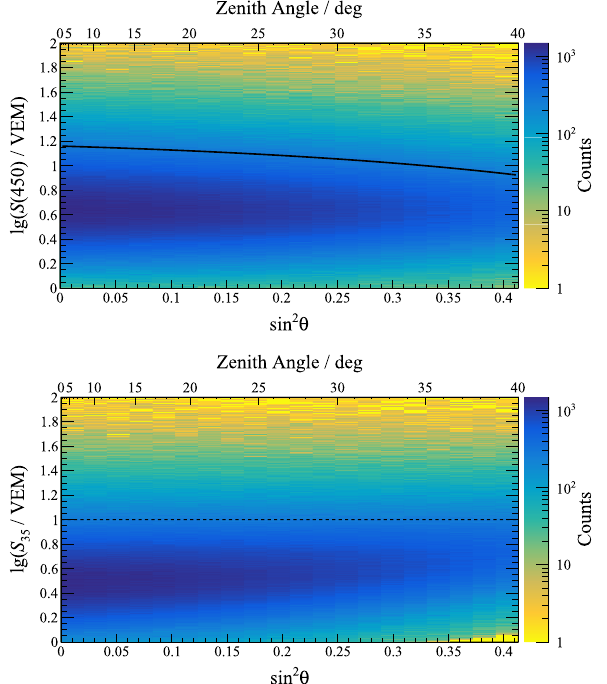
Fig. 6 Top:histogramofreconstructedshowersizesandzenithangles. The solid black line represents the shape of f CIC at 10VEM. Bottom: same distribution but as a function of corrected shower size, S 35 , and zenith angle. The dashed black line indicates the mapping of the solid black line in the top figure after inverting the effects of the CIC correc- tion